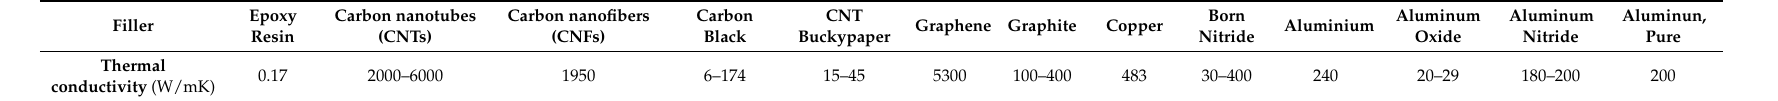
Table 2. Thermal conductivity of different fillers.